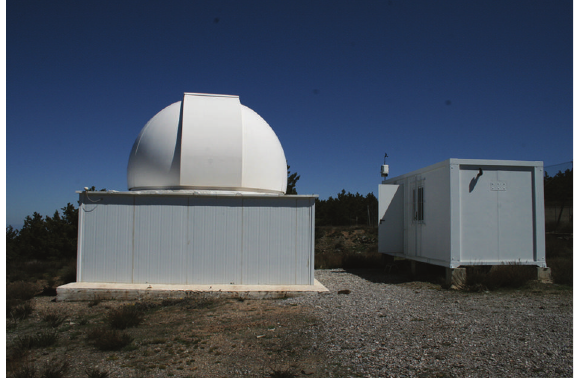
Figure 5: Observation station at Calar Alto Observatory. There is an auxiliary building with the wheater station and the control